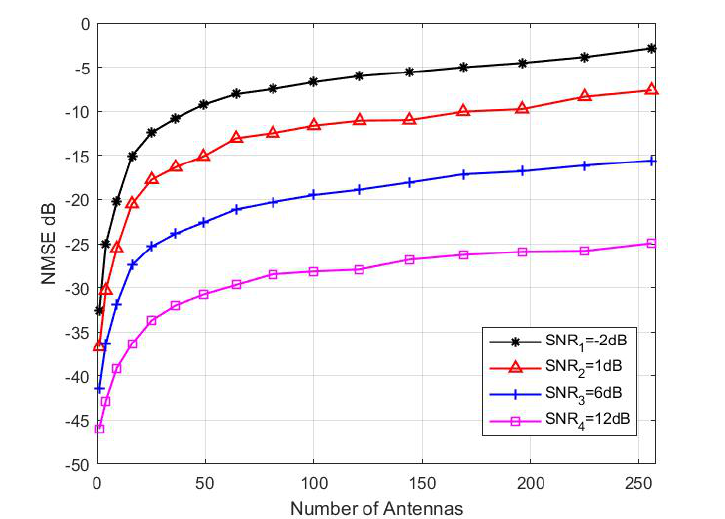
Figure 10. The relationship between the number of antennas and NMSE.